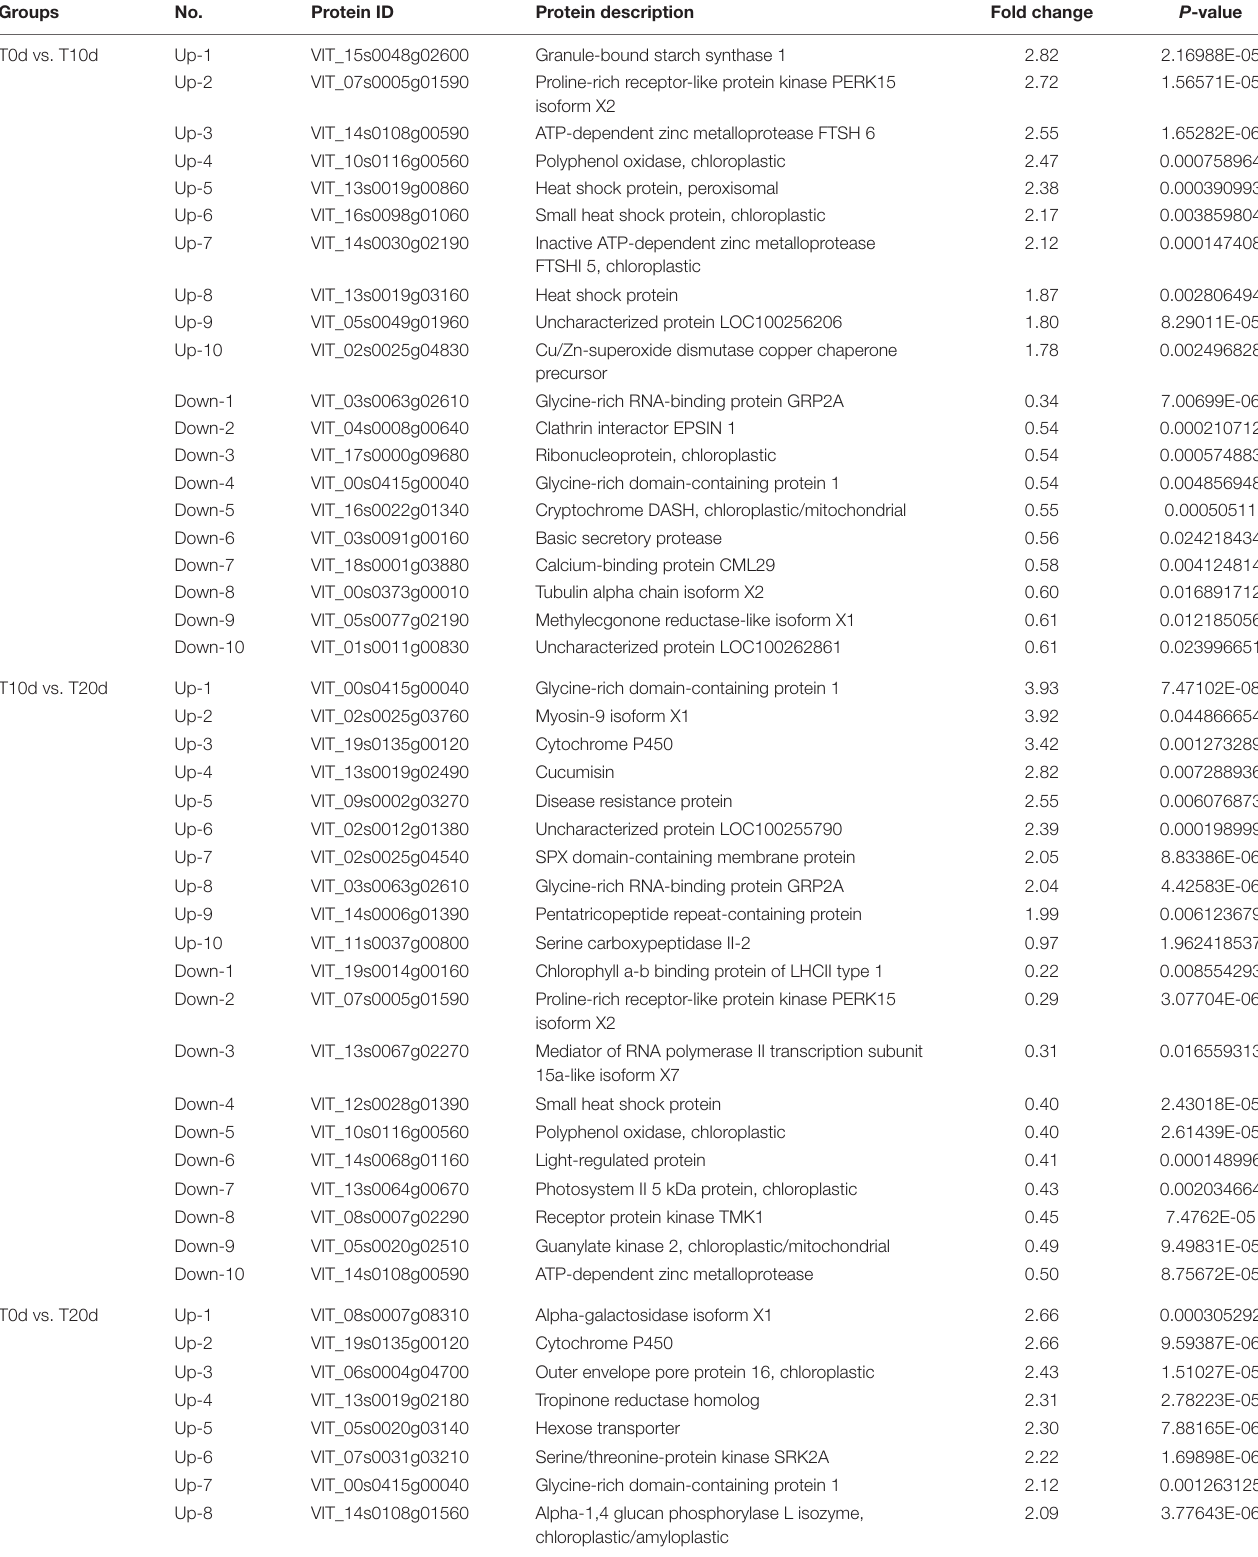
TABLE 1 | Top 10 differentially expressed proteins whose expression was upregulated and downregulated between groups. Groups No. Protein ID Protein description Fold change P